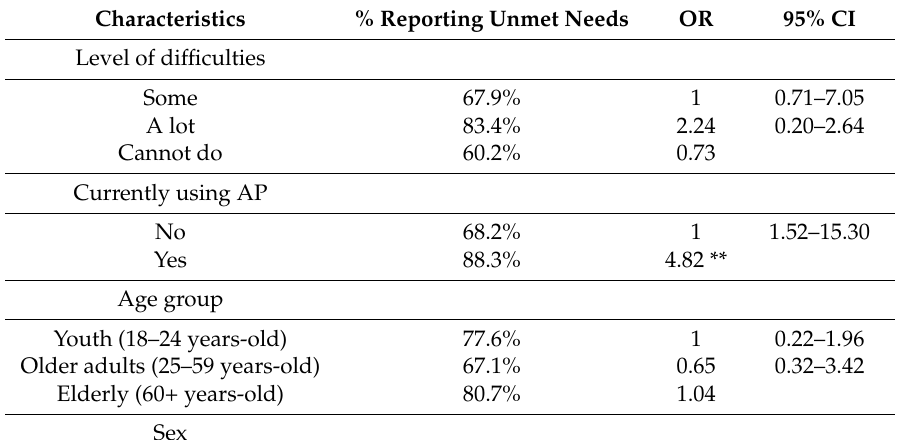
Table 3. Unadjusted percentage of people reporting unmet needs and factors associated with self-reported unmet needs.